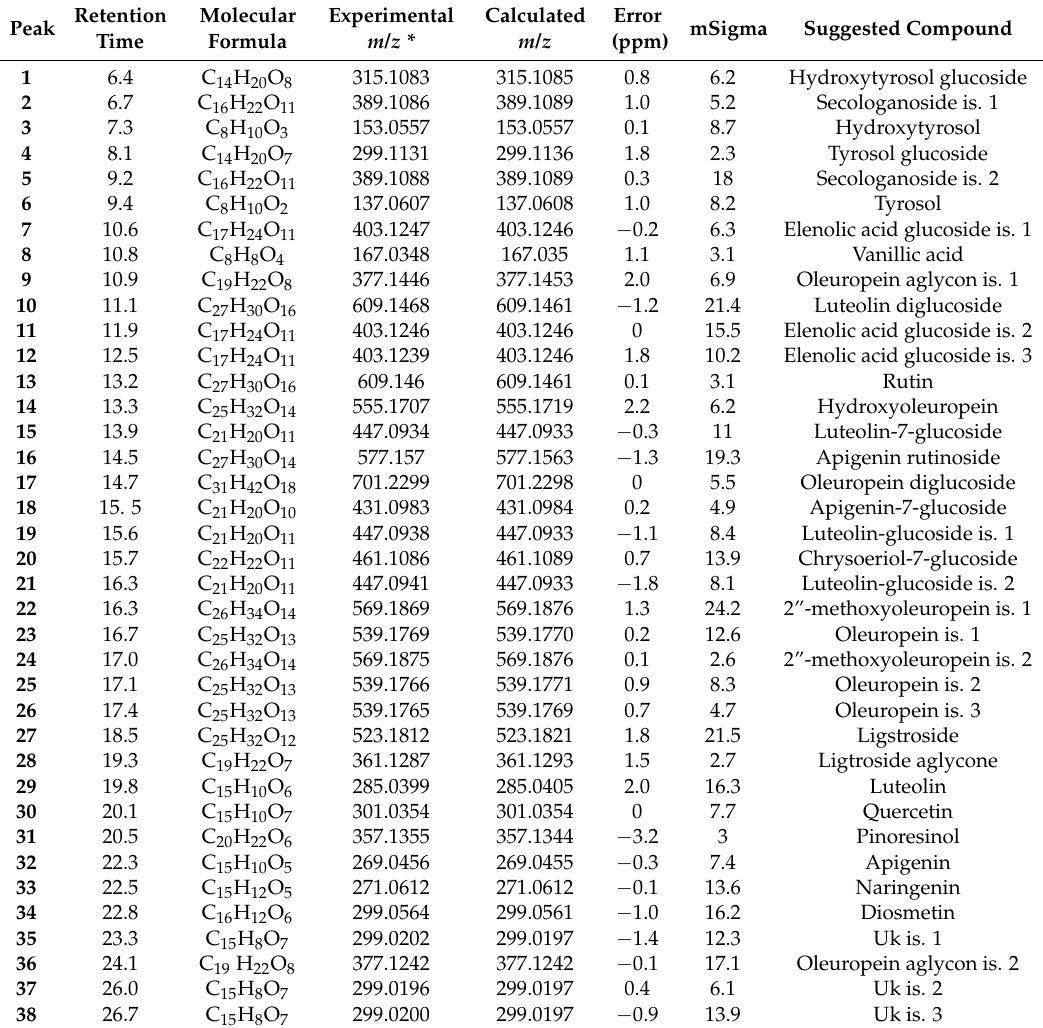
Table 1. Main phenolic compounds tentatively identified in the olive leaves from the 11 different selected varieties using the optimized LC-ESI-Q-TOF MS profiling